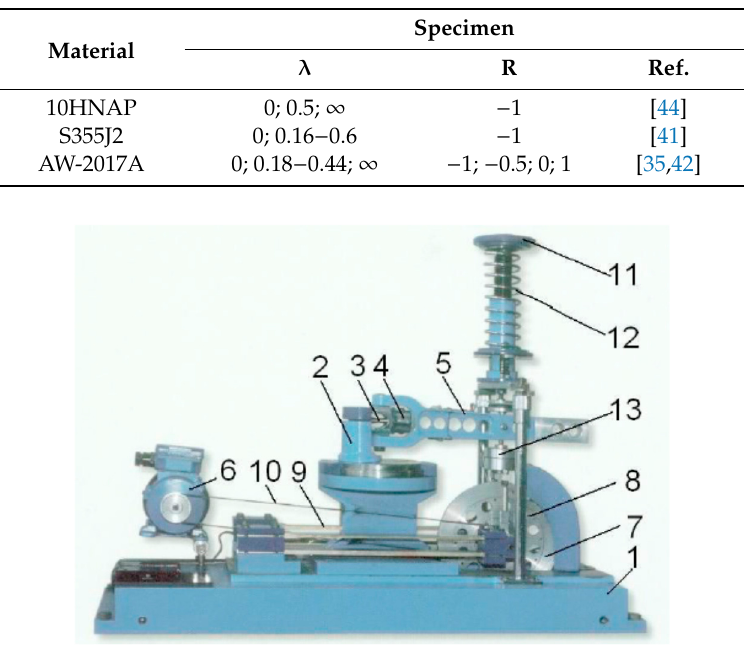
Figure 2. MZGS-100 fatigue test stand where: 1—bed, 2—rotational head with a holder, 3—specimen, 4—holder, 5—lever (e ff ective length = 0.2 m), 6—motor, 7—rotating disk, 8—unbalanced mass, 9—flat